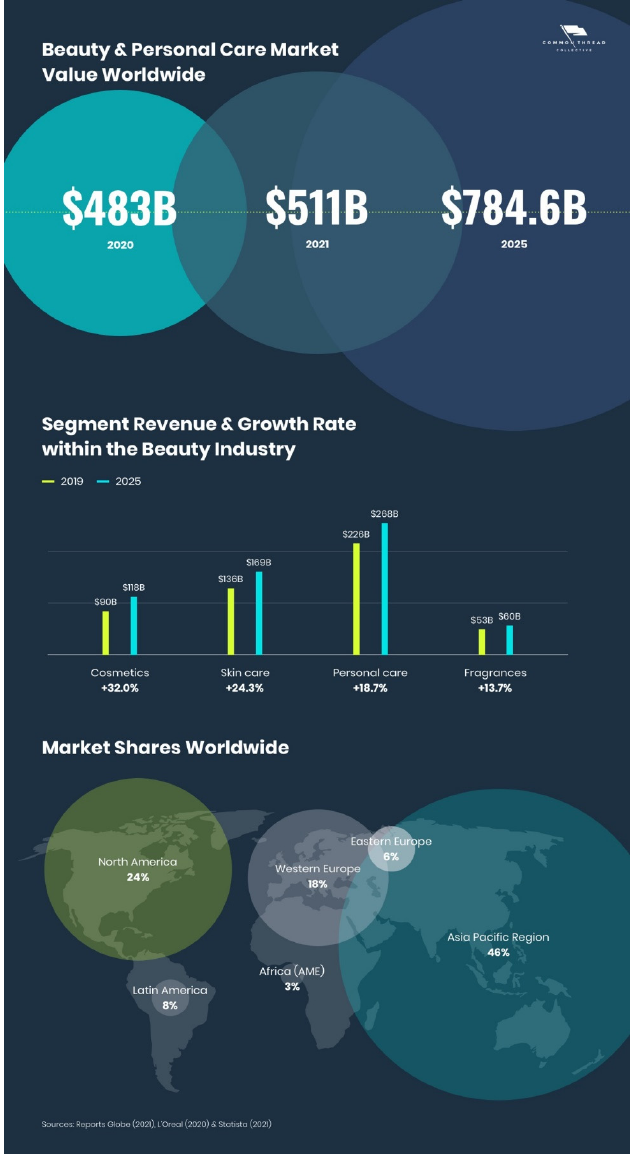
Figure 10. Beauty Industry Trends 2020–2025 (Reprinted with permission from Common Thread (2021) [96]).